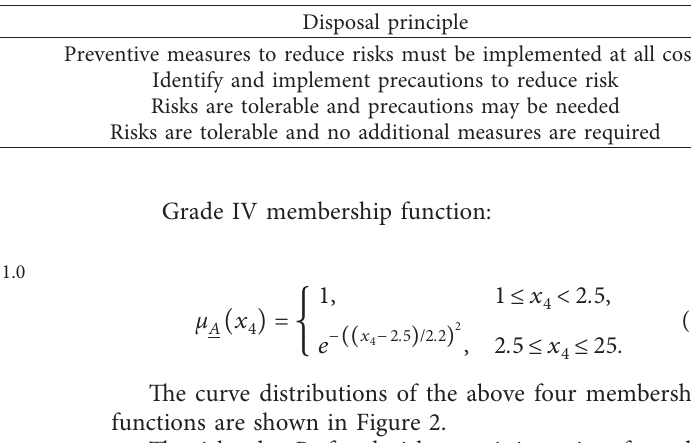
Table 5: Risk classification